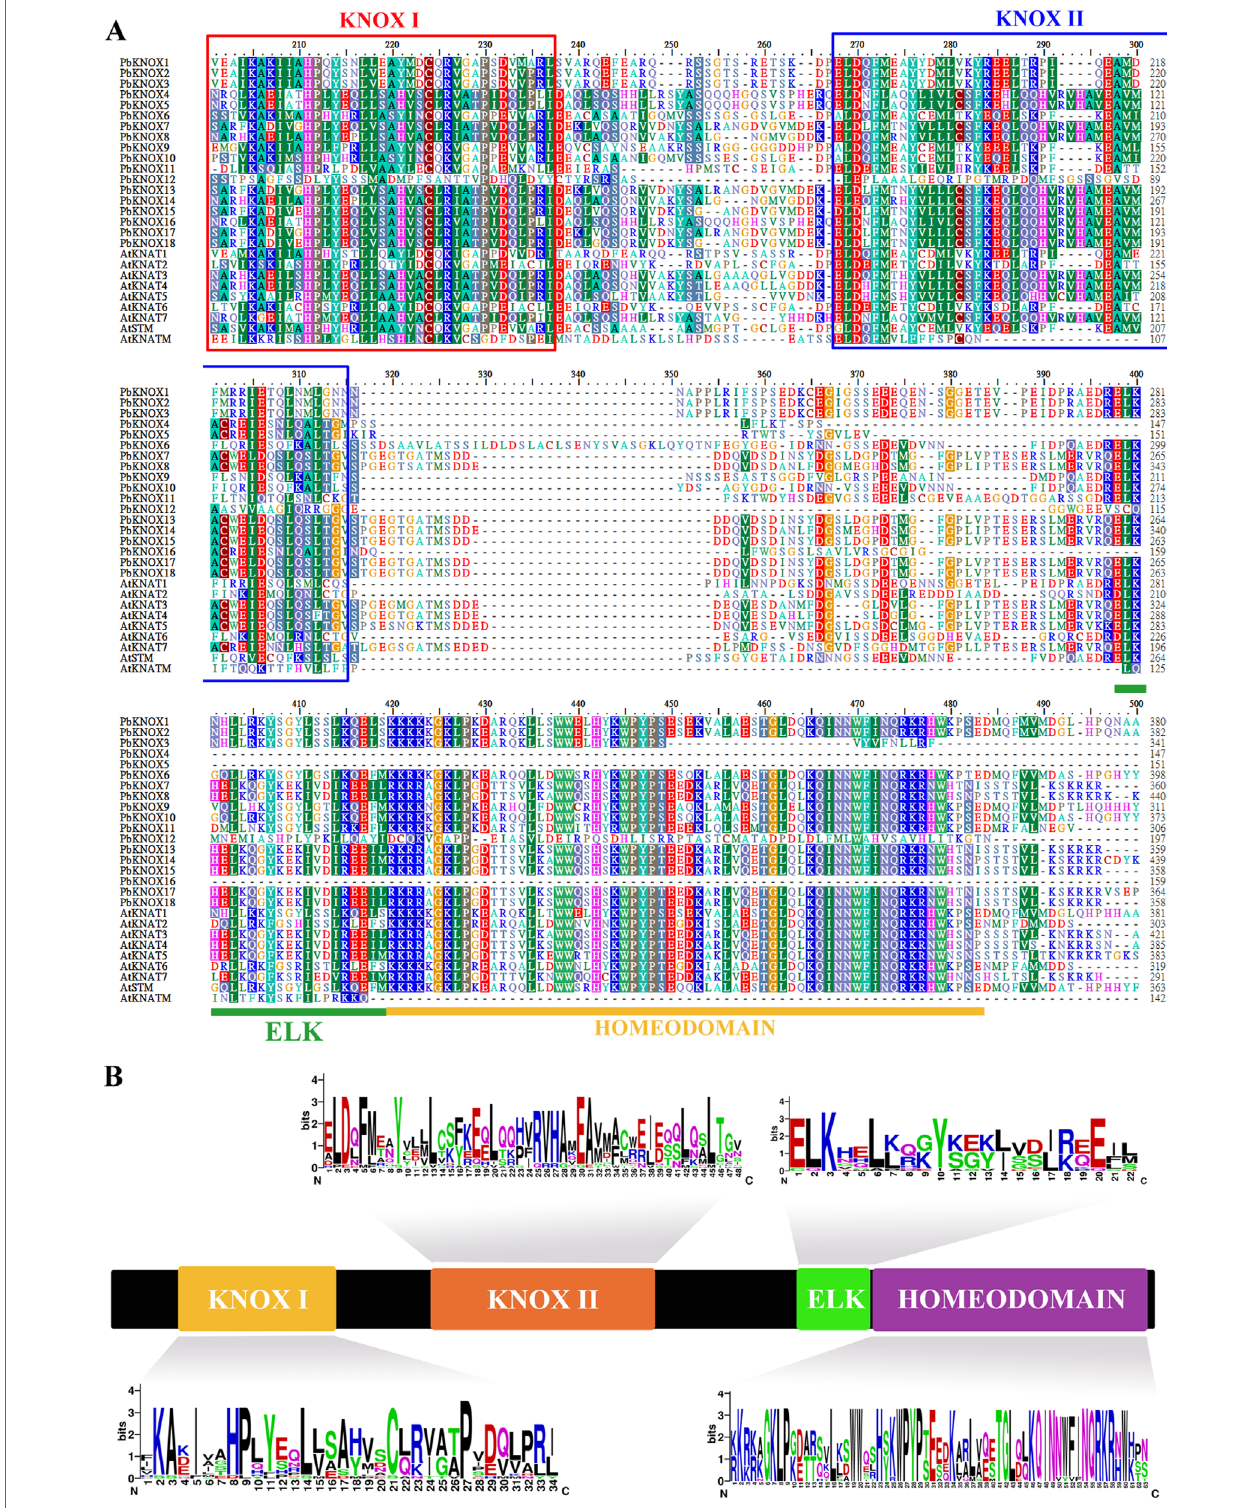
FIGURE 1 | Multiple sequence alignment and domain compositions of PbKNOX proteins. (A) Multiple sequence alignment of KNOX proteins from various plants. (B) The distribution and composition of the characteristic motifs of PbKNOX proteins. The bit score represents the information content for each position in the sequence. The logo consists of stacks of symbols, one stack for each position in the sequence. The overall height of the stack indicates the sequence conservation at that position, while the height of symbols within the stack indicates the relative frequency of each amino acid at that